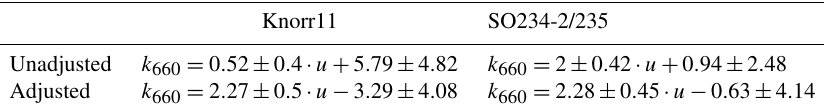
Table 2. Linear fits to the adjusted and unadjusted data sets of Knorr11 and SO234-2/235. The error estimates correspond to a 95% confidence